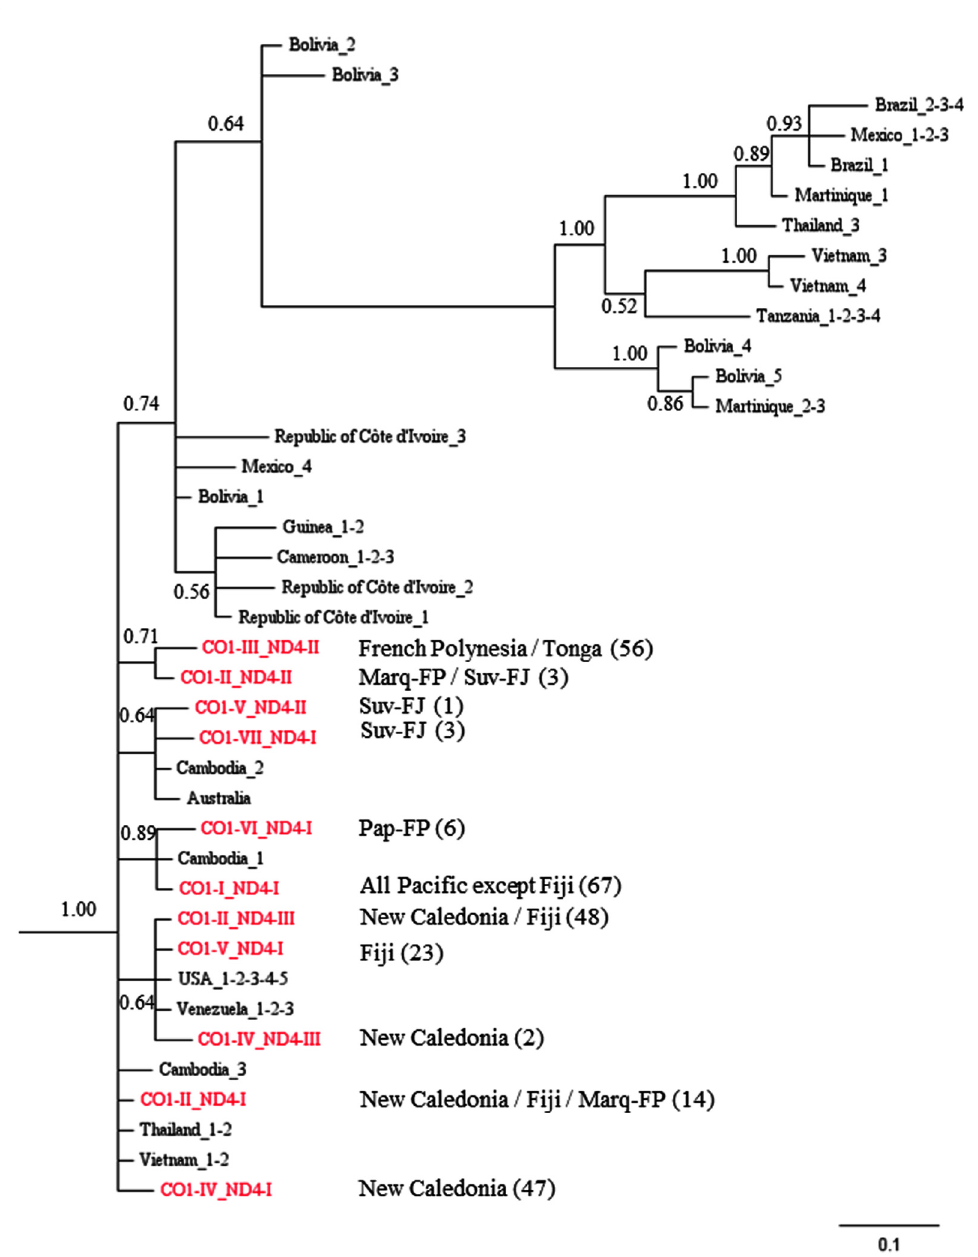
Fig 6. Phylogenetic tree obtained with a Bayesian inference of concatenated CO1 and ND4 sequence data. Numbers in parentheses indicate the number of samples belonging to this haplotype. For the Australian sample, only the CO1 sequence was available. Rooting was inferred from DNA sequences of Anopheles pullus and Culex quinquefasciatus but were not represented for